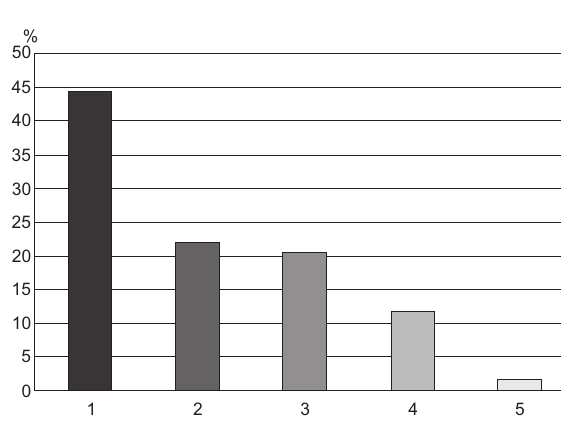
fig. 5. Use structure of public buildings in Polish